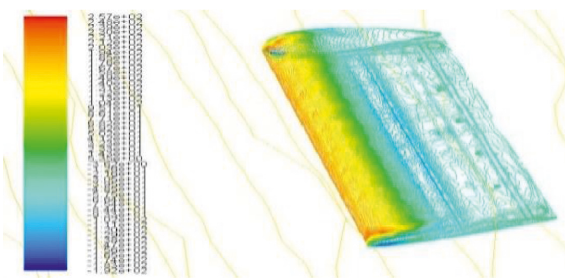
Figure 16: Total pressure at 10 ° AOA for the 3rd module.